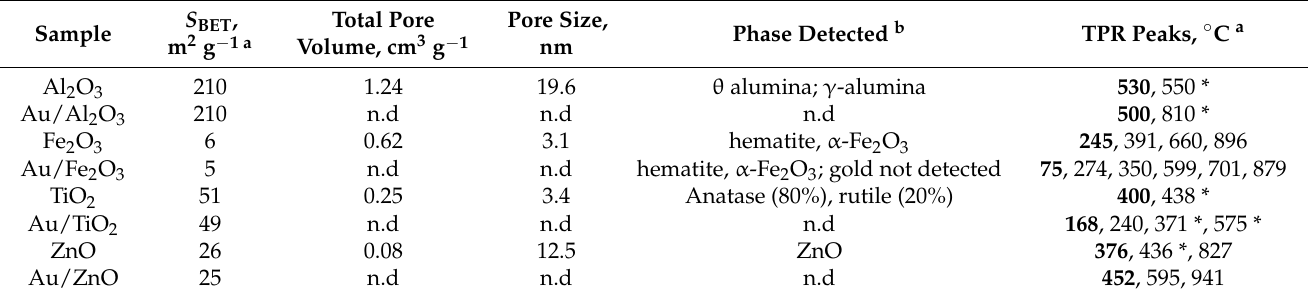
Table 1. Characterization of oxide supports by N 2 adsorption at − 196 ◦ C, phases detected by XRD, temperatures of TPR peaks.